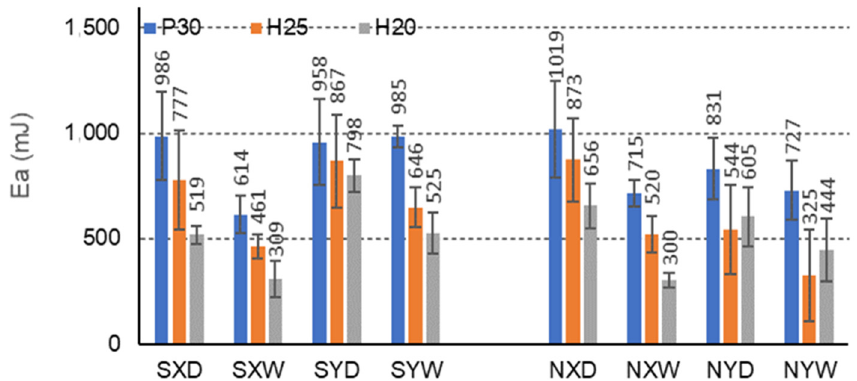
Figure 14. Illustration of the E a relationship of honeycomb panels with an E-type core. Whiskers represent standard deviations.